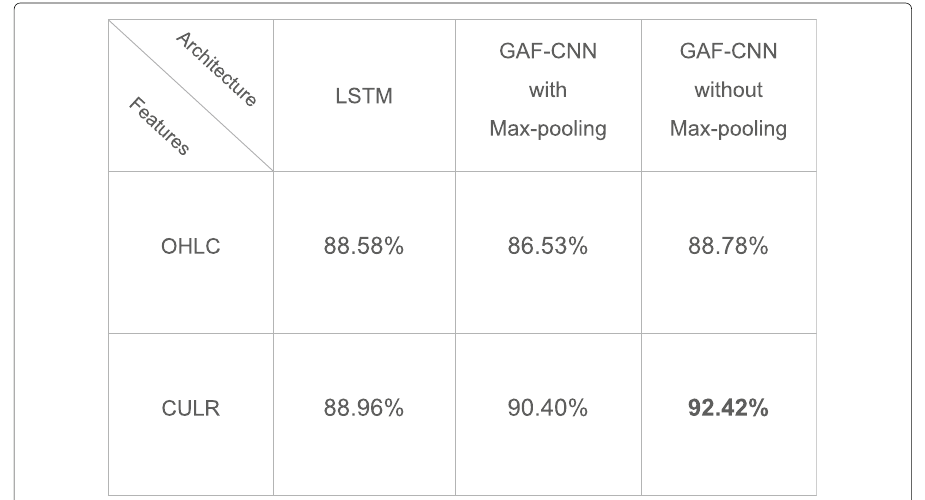
Fig. 12 The result is the difference between feature sets and neural architectures